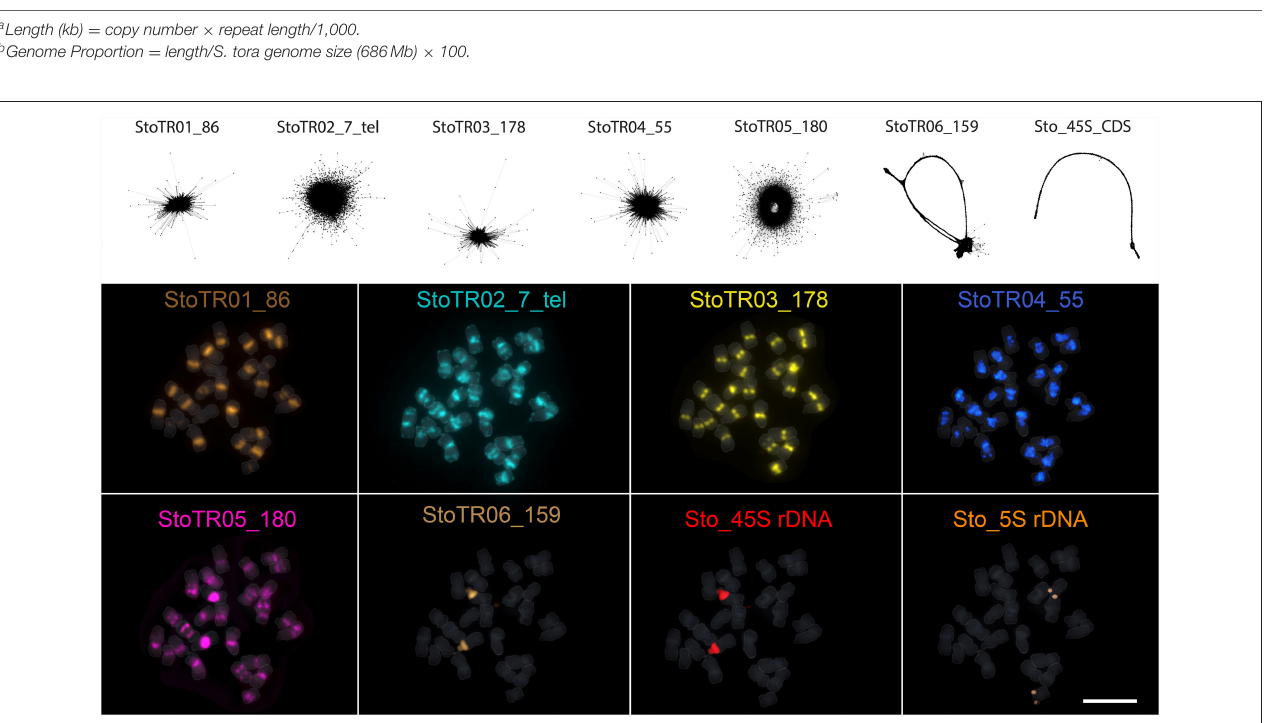
FIGURE 1 | Independent repeats identified through read clustering of < 1 × S. tora genome. The upper panel shows the read cluster graphs of the seven tandem repeats identified through TAREAN. No cluster data were generated for the 5S rDNA, which was identified using dnaLCW. The lower panel shows the chromosomal distribution of the eight repeats from the upper panel and the 5S rDNA. Bar = 10 µ